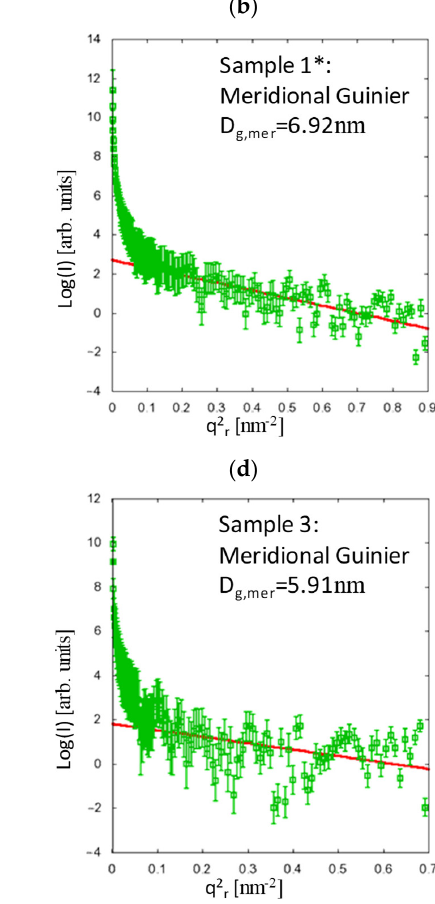
Figure 4. Analysis of the meridional scattering contributions using the Guinier fit for sample 1 ( a ), sample 1* ( b ), sample 2 ( c ) and sample 3 ( d ). The meridional dimensions depend, as expected, on both the spin-draw ratio and the draw ratio.